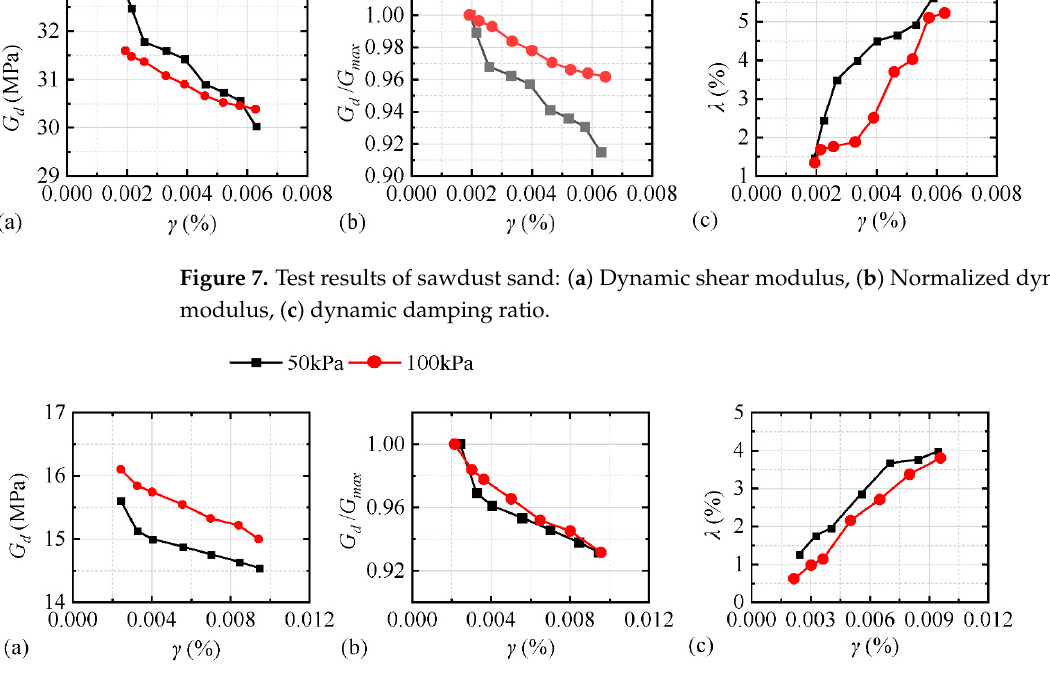
Figure 8. Test results of sawdust kaolin: ( a ) Dynamic shear modulus curve of sawdust kaolin, ( b ) Normalized dynamic shear modulus, ( c ) Dynamic damping ratio.